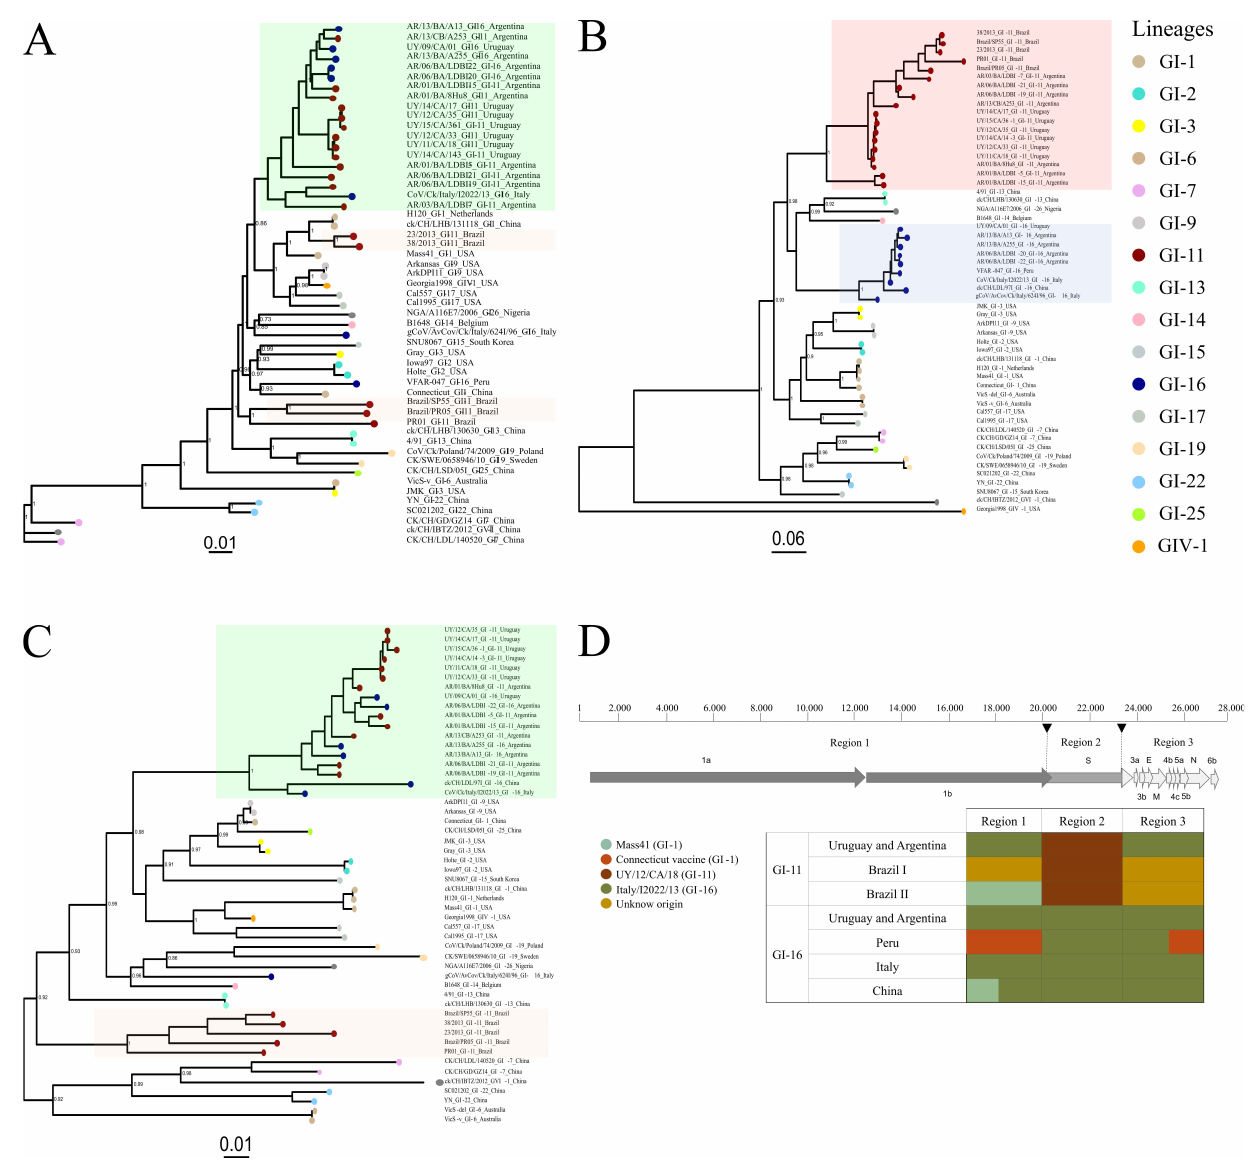
Figure 1. Phylogenetic trees were obtained with the maximum-likelihood method and JC model ( A ), GTR model with gamma distribution and invariant sites ( B ), and HKY model with gamma distribution and invariant sites ( C ). Phylogenetic reconstruction was carried out using the ORFs 1a and 1b ( A ), the most ORF S ( B ), and the last part of the S and ORFs 3a, 3b, E, M, 4b, 4c, 5a, 5b, and N ( C ). These analyses were performed using a sub-sampled non-recombinant data set with representatives of the IBV variability. Genomic organization of the GI-11 and GI-16 strains ( D ). The genome was divided into three regions for analysis and comparison; defined areas are indicated with shades of grey and delimited by two breakpoints (head arrow). The identity of each region (1 to 3) is indicated for the different GI-11 and GI-16 strains according to their similarity with IBV reference genomes (shown with different colors). Brazil I: PR01, PR05, and SP55. Brazil II: 23/2013 and